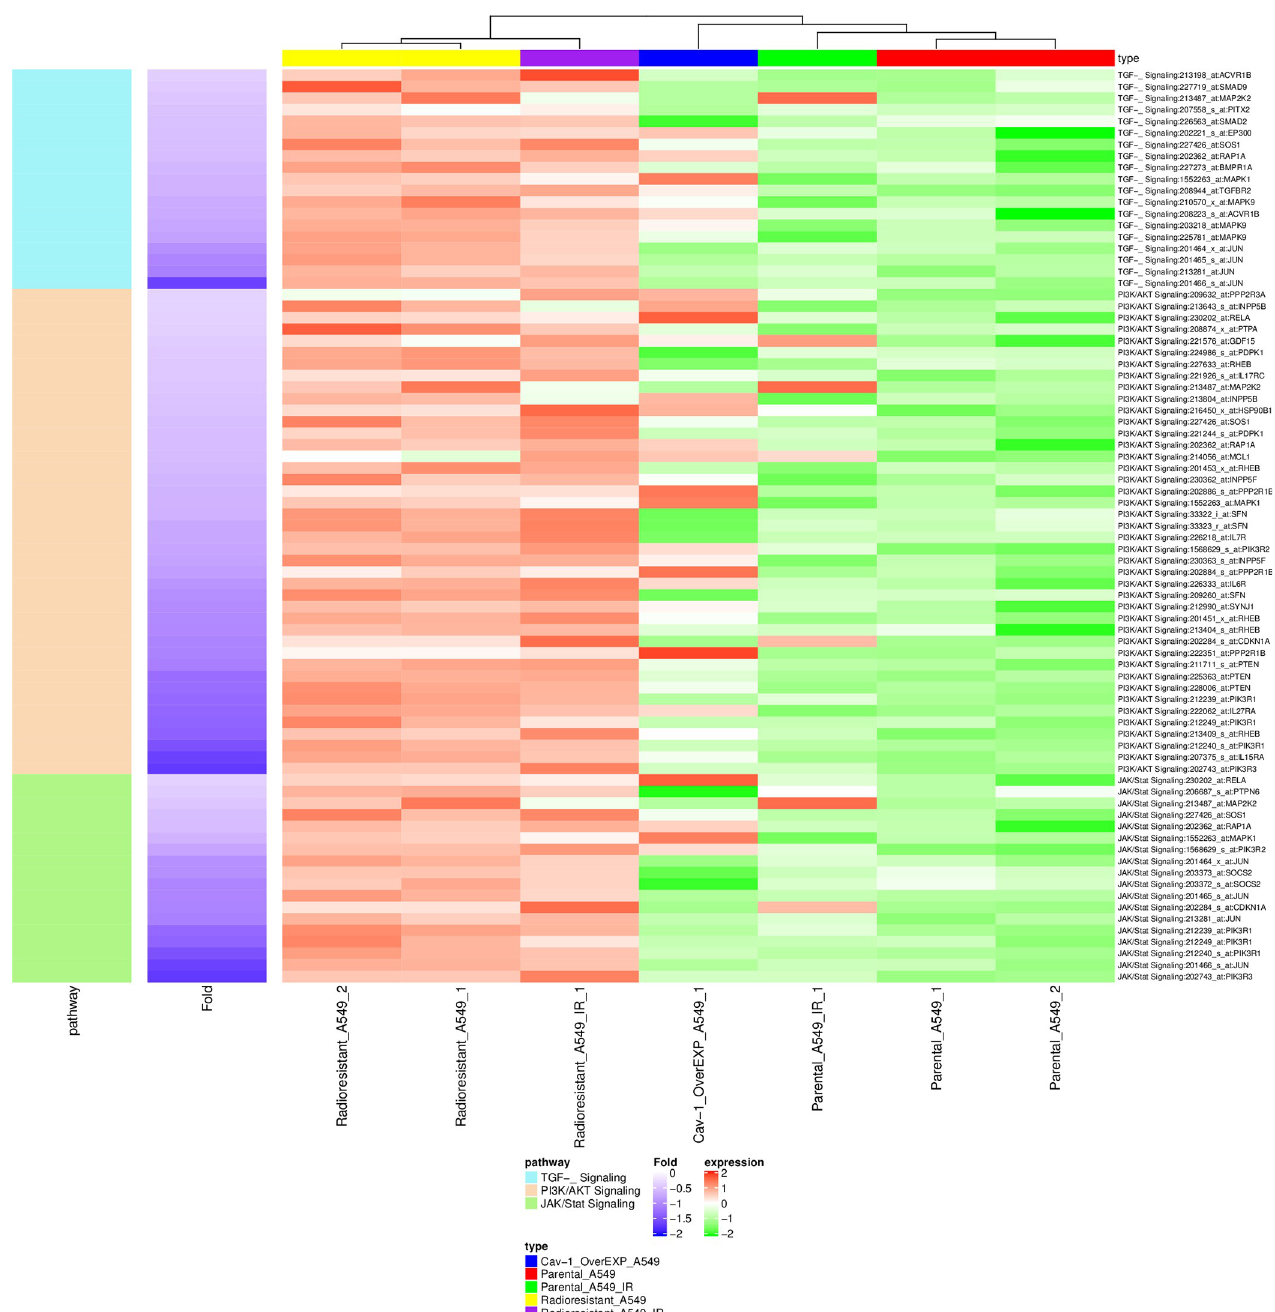
Fig 3. Heatmap analysis of gene expression profiling of parental A549, radioresistant and CAV-1 overexpressed cells.